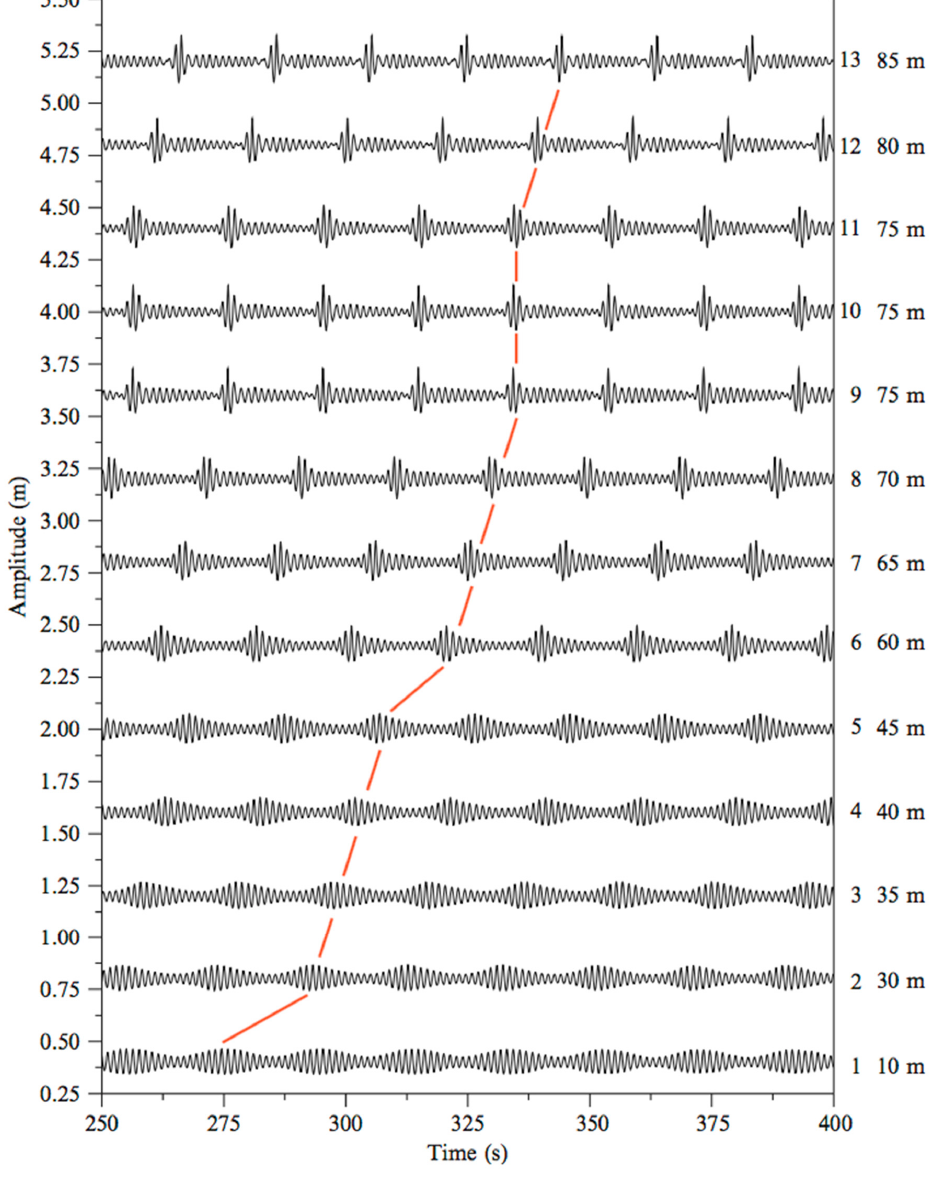
Figure 24. A 150 sec section of an experiment conducted at SINTEF in the long wave flume. Here a sine wave (carrier wave period of 1.3 sec) is given a small ‐ amplitude modulation (period 19.5 sec) at the wave maker at 0 m. Here 13 wave probes are shown ordered from the bottom to the top of the figure: See probe numbers and distances from wave maker on the right. About eight carrier modulations are shown. From the figure, we see that the sine wave created by the wave maker is modulationally unstable because the modulation has grown as it propagates from the wave maker to the first probe at 10 m. The modulation continues to grow and focus as the wave train propagates down the tank to a distance of 85 m. The smooth modulations near the wave maker are transformed during their propagation down the tank: Beyond about 70 m, the wave amplitudes consists of seven localized packets that we call breathers. This is one of the best experimental evidences of the long ‐ time evolution of the Benjamin ‐ Feir instability.